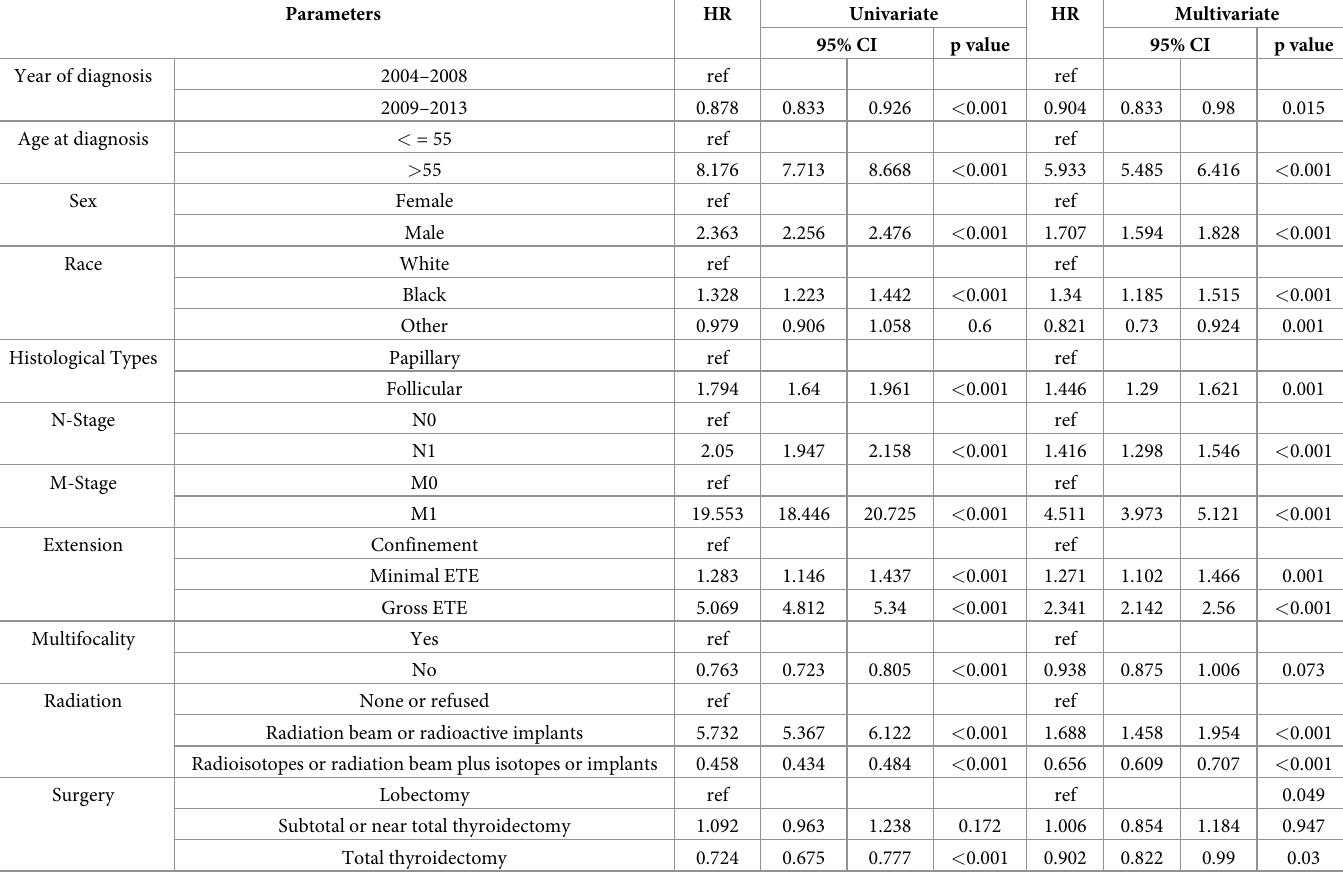
Table 5. Clinicopathologic parameters associated with the overall survival.